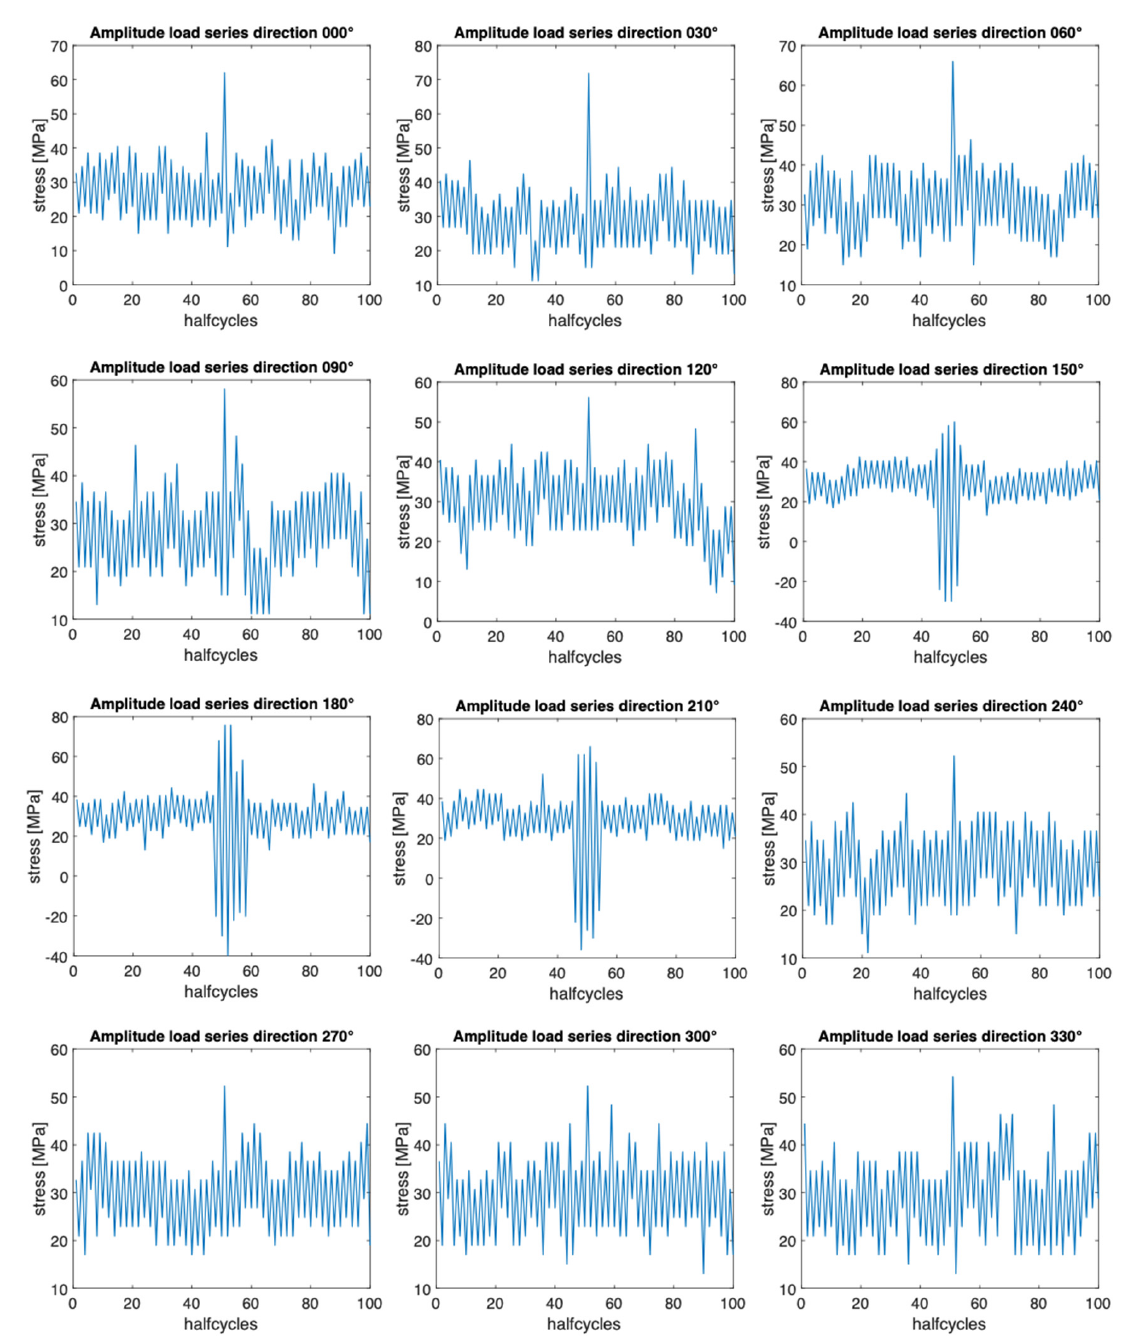
Figure 9. Stress-time around the maximum load obtained from the Markov chain method for each of the 12 sectors with an applied omission level of 10%.